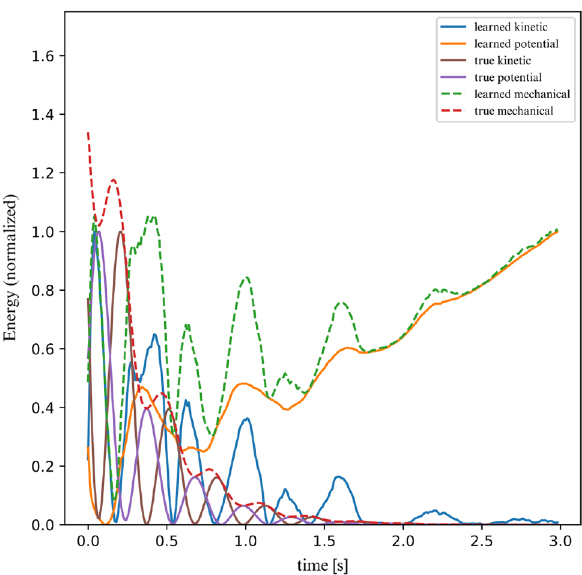
Figure 24. Linear dissipative 2DOF system energy.